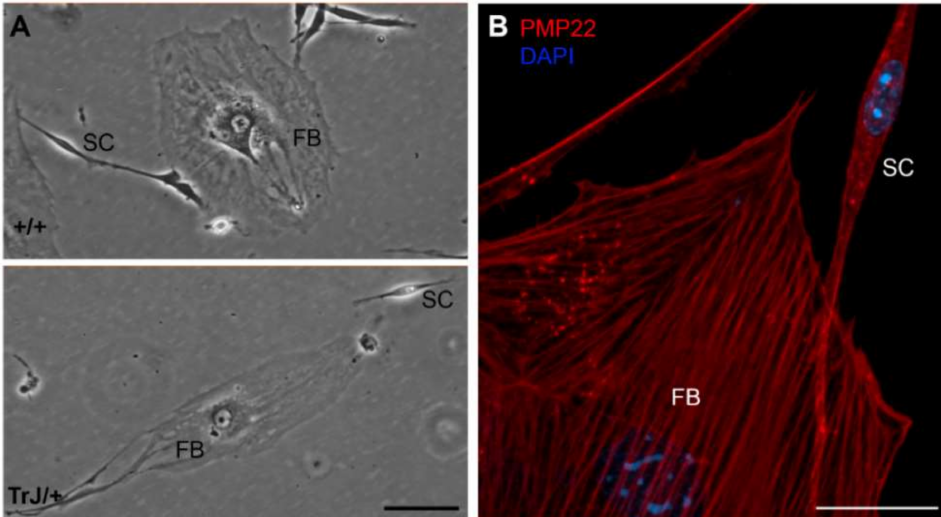
Figure 1. Morphology of different cell types in enriched SC cultures. ( A ) In both +/+ and TrJ/+ genotypes, fibroblasts (FBs) and Schwann cells (SC) show morphological differences. FBs show a heterogeneous flattened shape with abundant cytoplasm and a large nucleus easily distinguishable under light microscopy. SCs show typically bipolar shape with lateral extensions and a smaller size compared to FBs; ( B ) Confocal microscopy image showing PMP22 (red) and nuclear labeling counterstain (DAPI, blue). Scale in ( A ) = 250 µ m. Scale in ( B ) = 20 µ m.